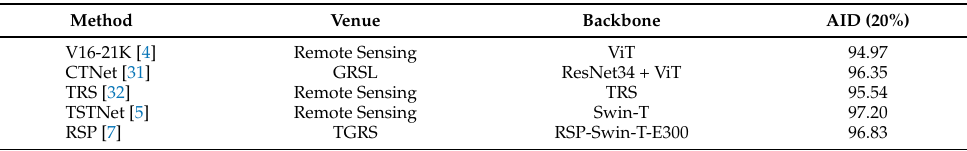
Table 1. Performance, in terms of classification accuracy, of different transformer-based methods on the popular AID dataset with 20:80 train-test